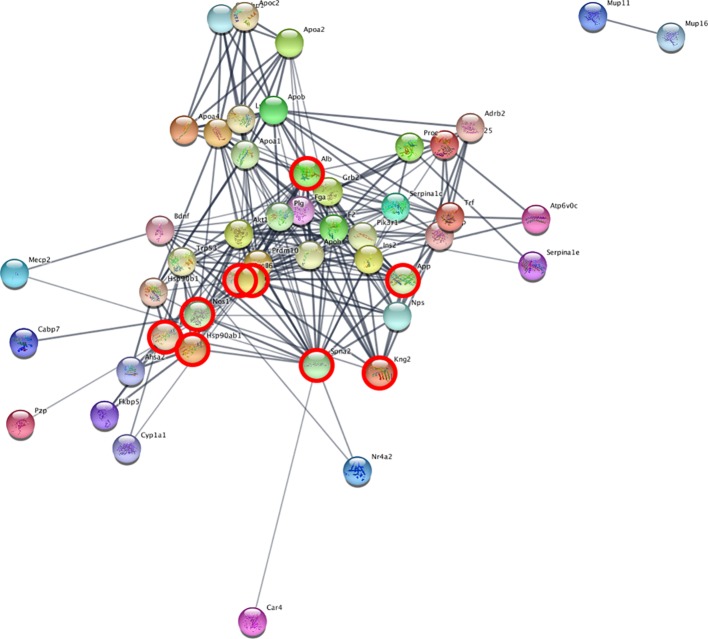
Network analysis reveals interacting genes across cerebellum and blood. STRING analysis network of cerebellum DE genes. The highlighted nodes correspond to proteins overlapping between blood and cerebellum.